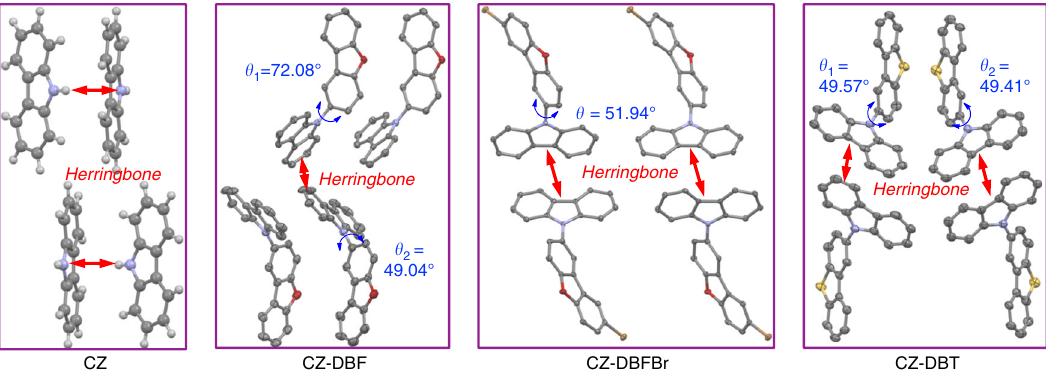
Fig. 5 Crystal structures of CZ, CZ-DBF, CZ-DBFBr, and CZ-DBT. Carbon, hydrogen, oxygen, nitrogen, sulfur, and bromine atoms are shown as gray, white, red, blue, yellow, and orange balls (for CZ) or ellipsoids (for CZ-DBF, CZ-DBFBr, and CZ-DBT) at the 50% probability level